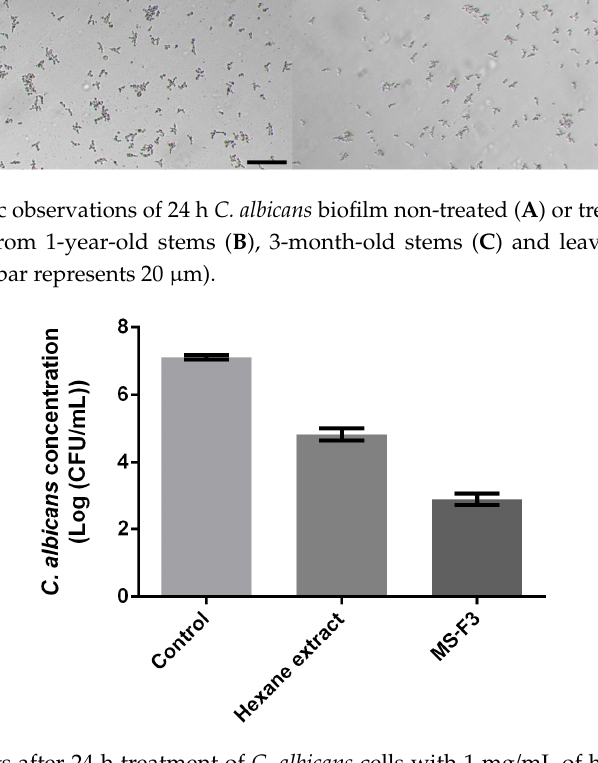
Figure 4. CFU counts after 24 h treatment of C. albicans cells with 1 mg/mL of hexane extract from 3-month-old stems, MS-F3 or without treatment.